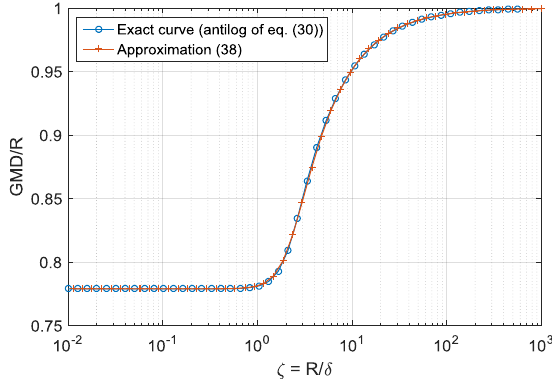
Figure 4: Semi logarithmic plot of the relative GMD in function of the dimensionless frequency